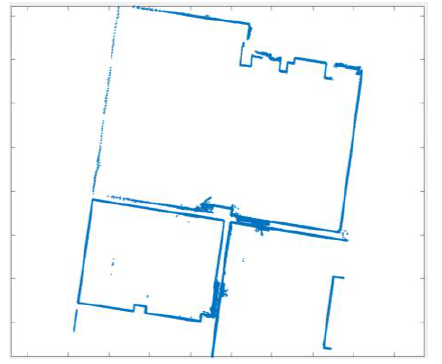
Figure 7. 2D SLAM-based point clouds of the best section As can be seen in Figure 8, some voxels with similar colors and directions should be grouped into different individual line segments. In addition, some voxels with similar colors and directions should be merged as a single line due to undesirable gaps between them.